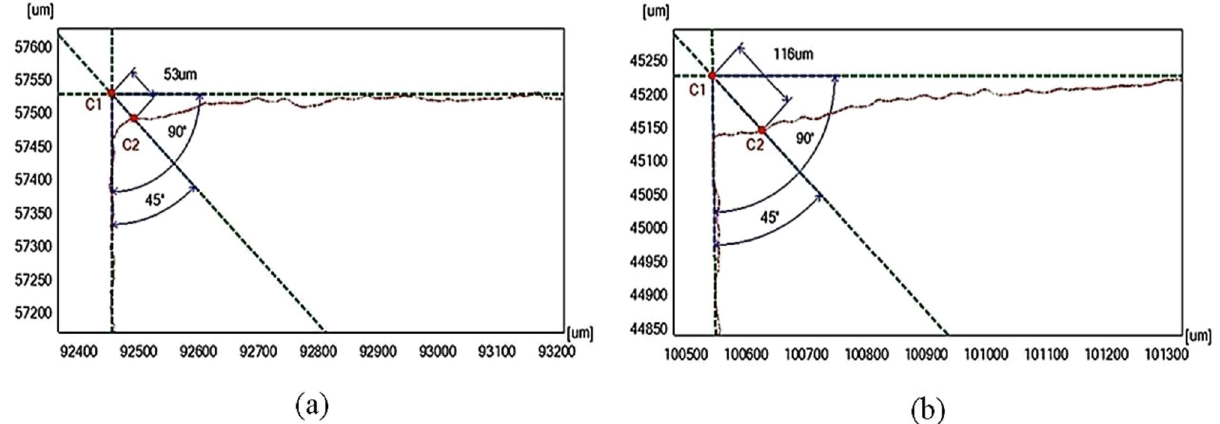
Fig. 7. Corner pro fi le traced by CV 3200 high precision contour scope (a) T on =0.5 m s (b) T on = 0.9 m s.